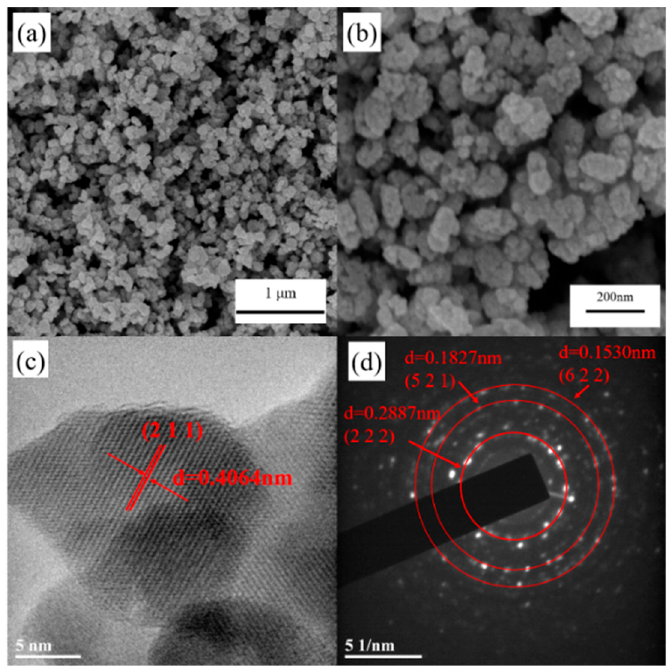
Figure 4. The morphology and microstructure of ITO nanoparticles: ( a , b ) SEM; ( c ) HRTEM; and ( d ) SAED.